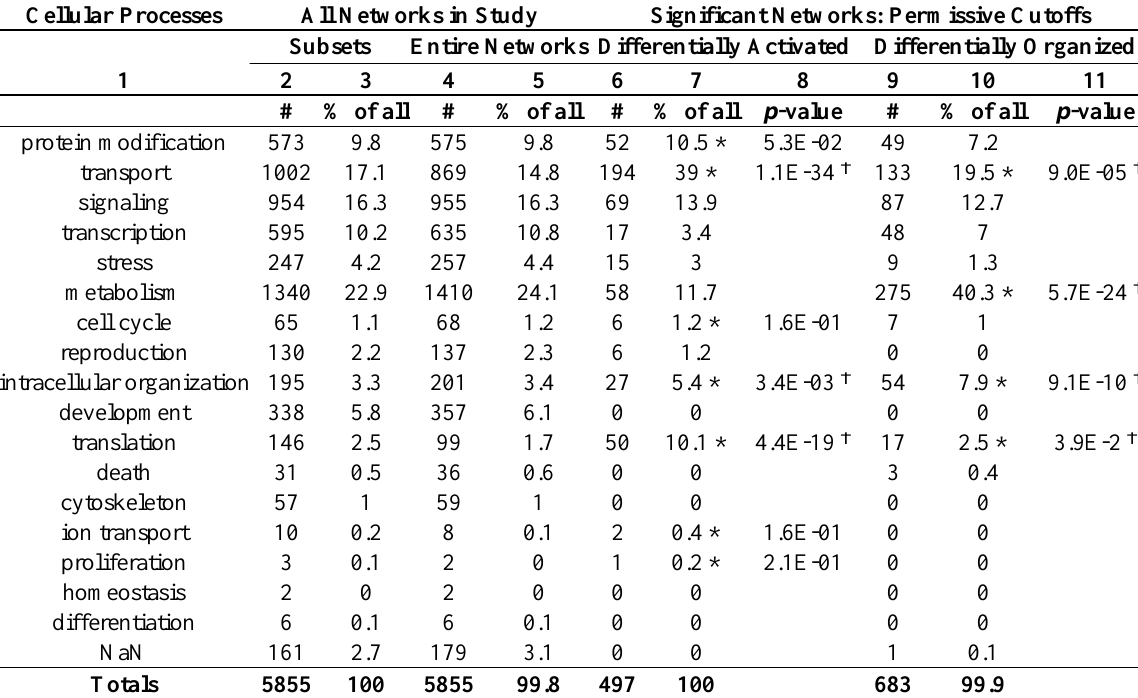
Table 1. Enrichment of genetic networks in metastatic osteosarcomas according to cellular processes at the global (Permissive) significance level.